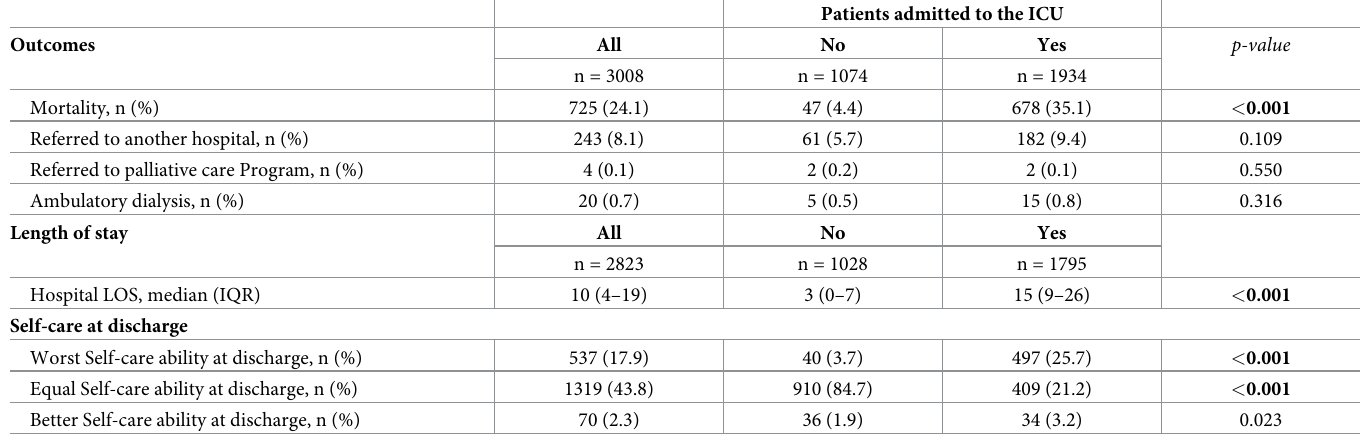
Table 2. Clinical outcomes.